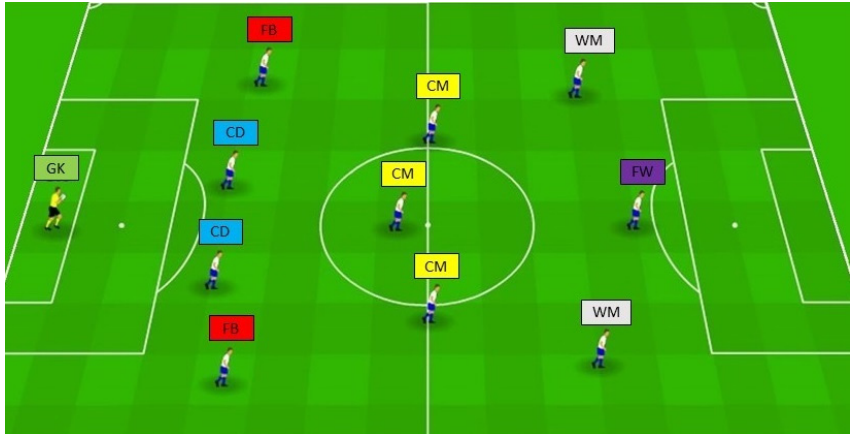
Figure 1. Classification of playing positions; CD = Central defenders, FB = Fullbacks, CM = Central midfielders, WM = Wide midfielders, FW = Forwards, GK = Goalkeepers.